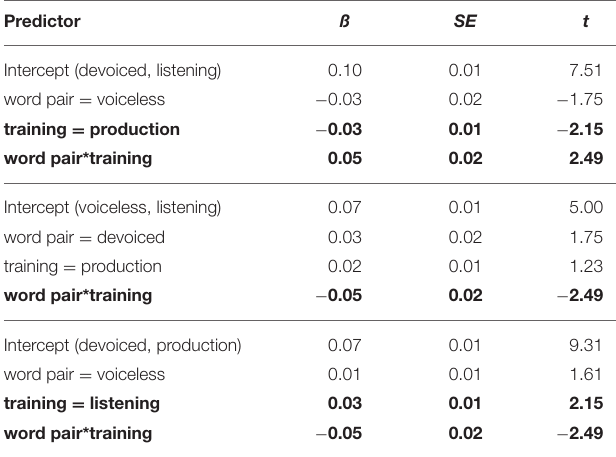
TABLE 1 | Results for burst intensity differences between training and test words as calculated by the model lmer (burst difference ∼ word pair * training + (1 + word pair|participant) + (1 +